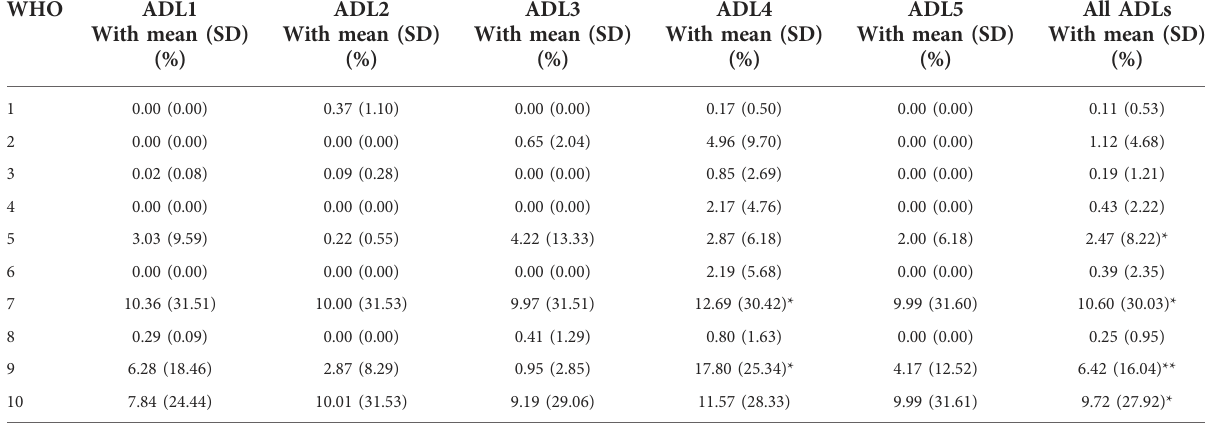
TABLE 7 Percentage of time that the wrist was in fl exion and ulnar deviation during each ADL and by each WHO.